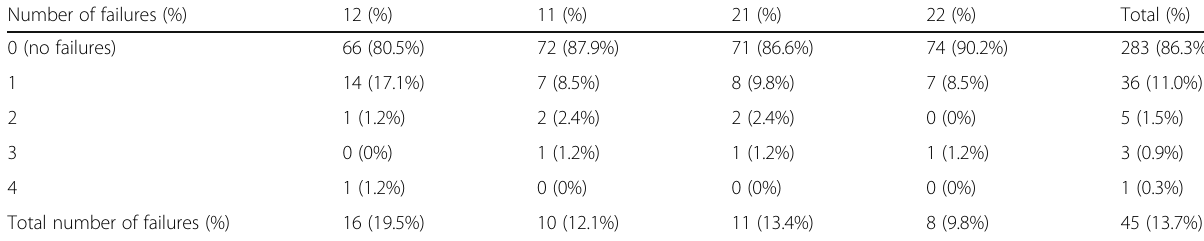
Table 7 Number of failures according to tooth type in the maxilla for the .016 ″ × .022 ″ braided SS retainers bonded to 4 incisors (82 patients, 328 bonded